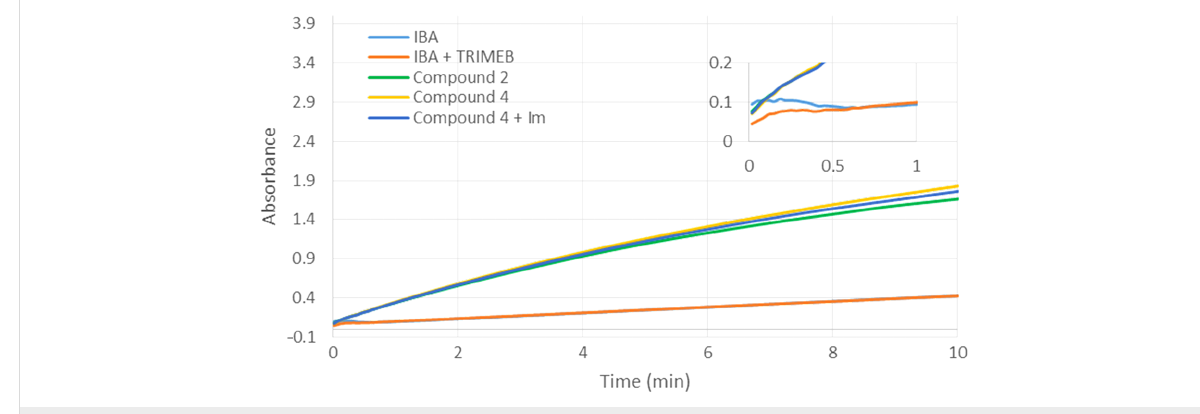
on the hydrolytic activity, irrespective of the nature of the pesti- cide. Moreover, the hydrolysis rate of methyl parathion in the presence of imidazole and derivative 4 did not change when compared to scavenger 2 . This result confirms the importance to introduce the imidazole at a specific distance from the reactive group. It is important to note that, contrary to methyl paraoxon, in the case of methyl parathion, the use of an equimolar mix- ture of IBA and TRIMEB didn’t affect the degradation of the pesticide compared to IBA alone. The influence of the intermo- lecular interactions between the pesticides and the methylated oligosaccharide is of fundamental importance towards the deg- radation process.